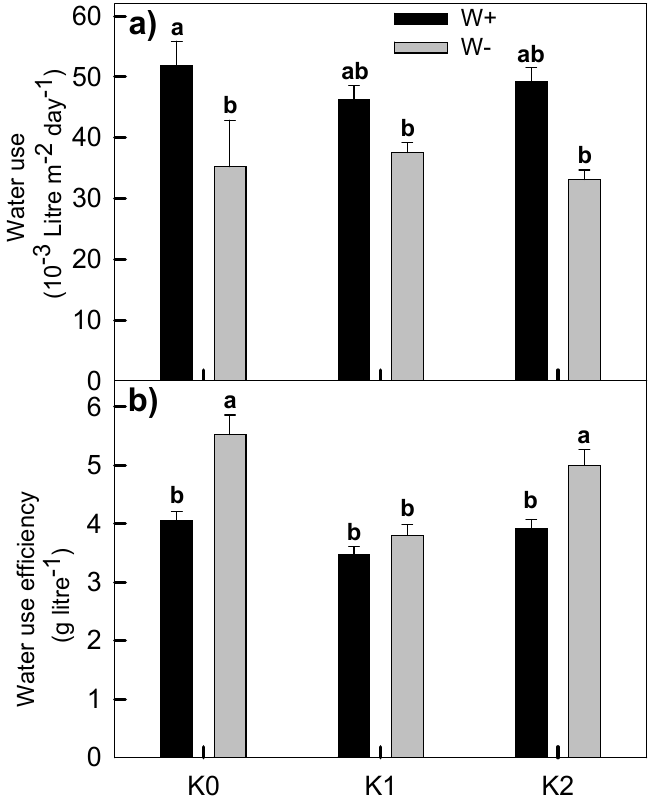
Figure 6. ( a ) Transpiration per unit time and per unit leaf area, and ( b ) water use efficiency calculated for the period with corn plants subjected to water shortage of well-watered (W+, black bars) and water stressed (W − , grey bars) as a function of three potassium levels (K0 = low, K1 = normal, K2 = high; mean ± Standard Error; n = 7). Statistics are summarized in Table 1. Letters represent significant differences at a 5% level.